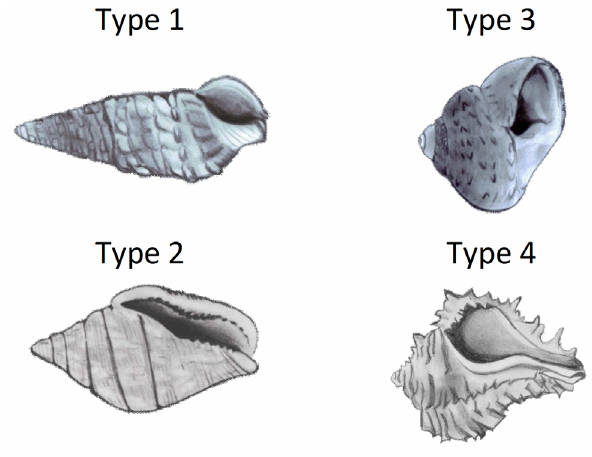
Figure 3. Schematic drawings representative of each shell